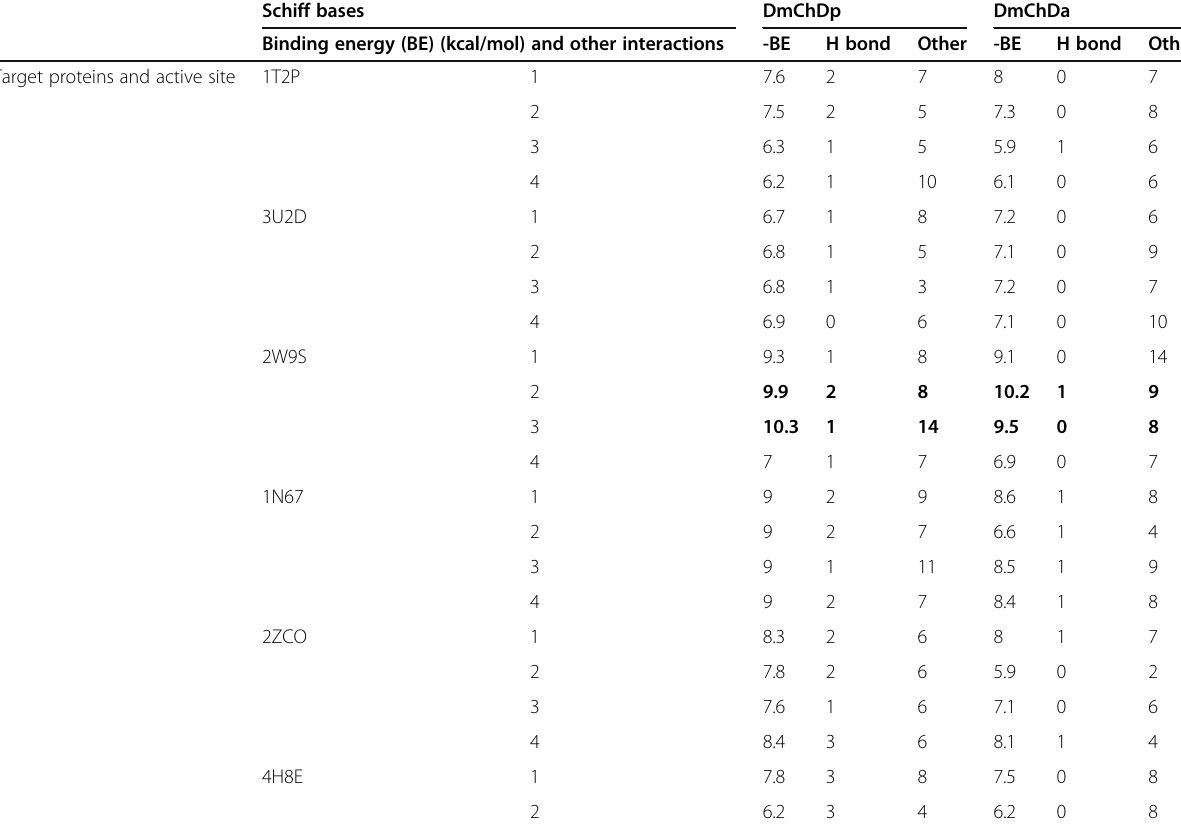
Table 3 Binding energy and number of interactions of Schiff bases docked with target proteins in S . aureus Schiff bases DmChDp DmChDa Binding energy (BE) (kcal/mol) and other interactions -BE H bond Other -BE H bond Other Target proteins and active site